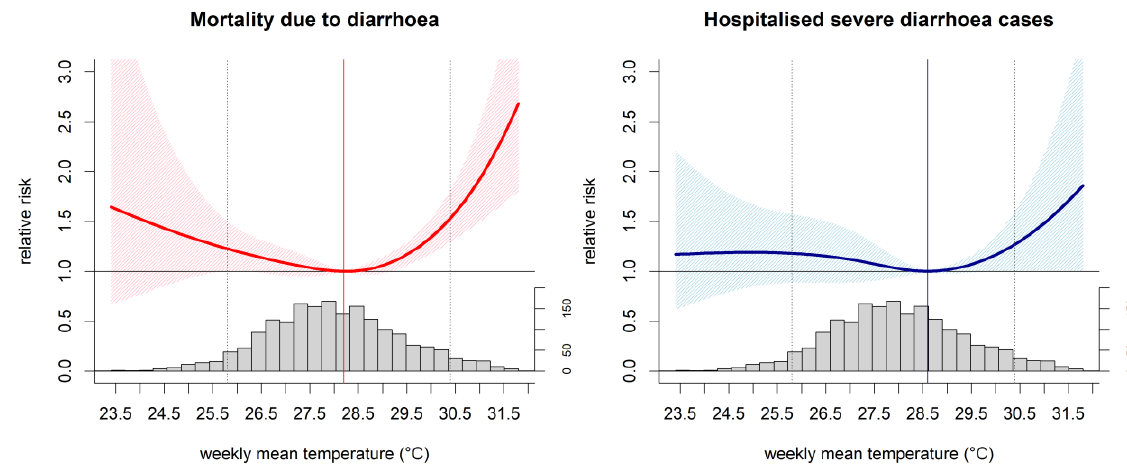
Figure 2. Cumulative associations between weekly mean temperature and diarrhoea in the National Capital Region in 2006–2017. Curves are the relative risks, polygons are the 95% confidence intervals, vertical lines are the minimum risk temperatures, grey dotted lines are 5th and 95th temperature percentiles, and grey histograms are the temperature distri- butions.